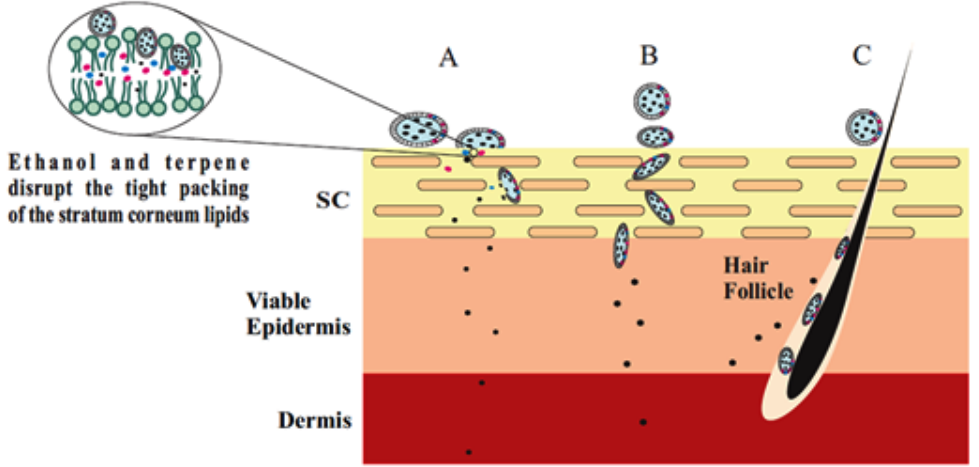
Figure 3. Penetration mechanism of invasomes through the stratum corneum (SC).